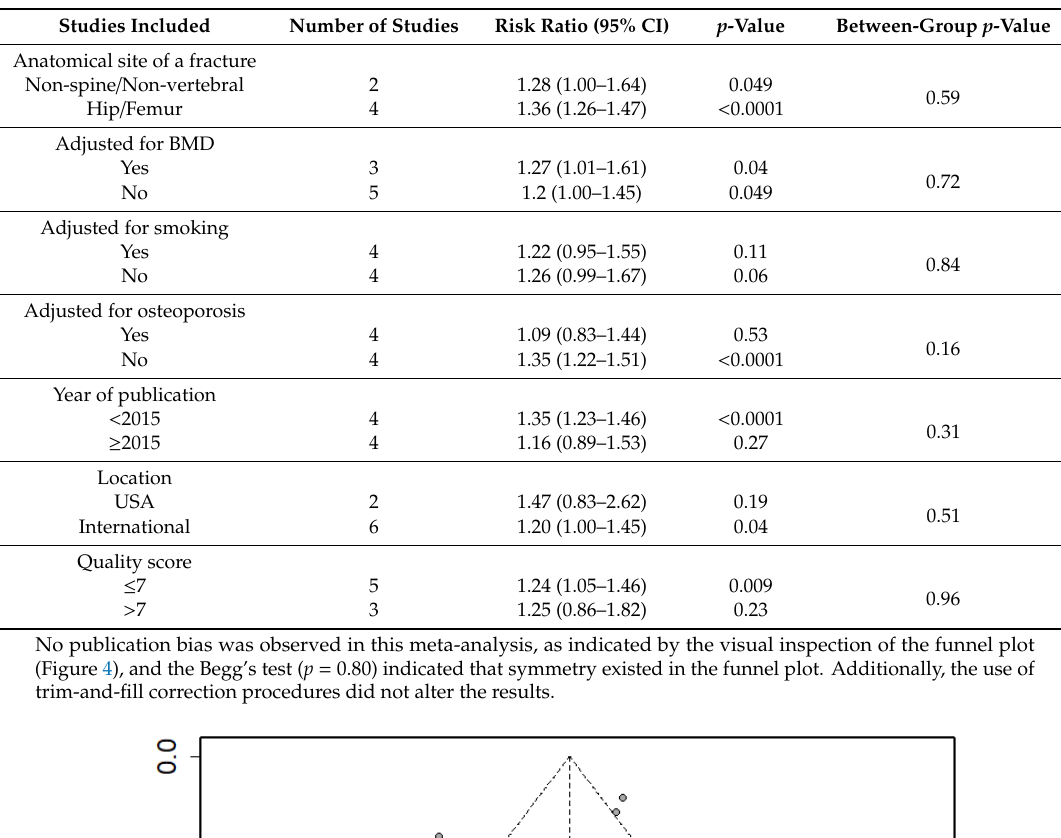
Table 3. Fracture risk associated with the use of tricyclic antidepressants in the subgroups analysis defined by the following characteristics: anatomical site of fracture, confounder adjustment, years of publication, study location and quality score.